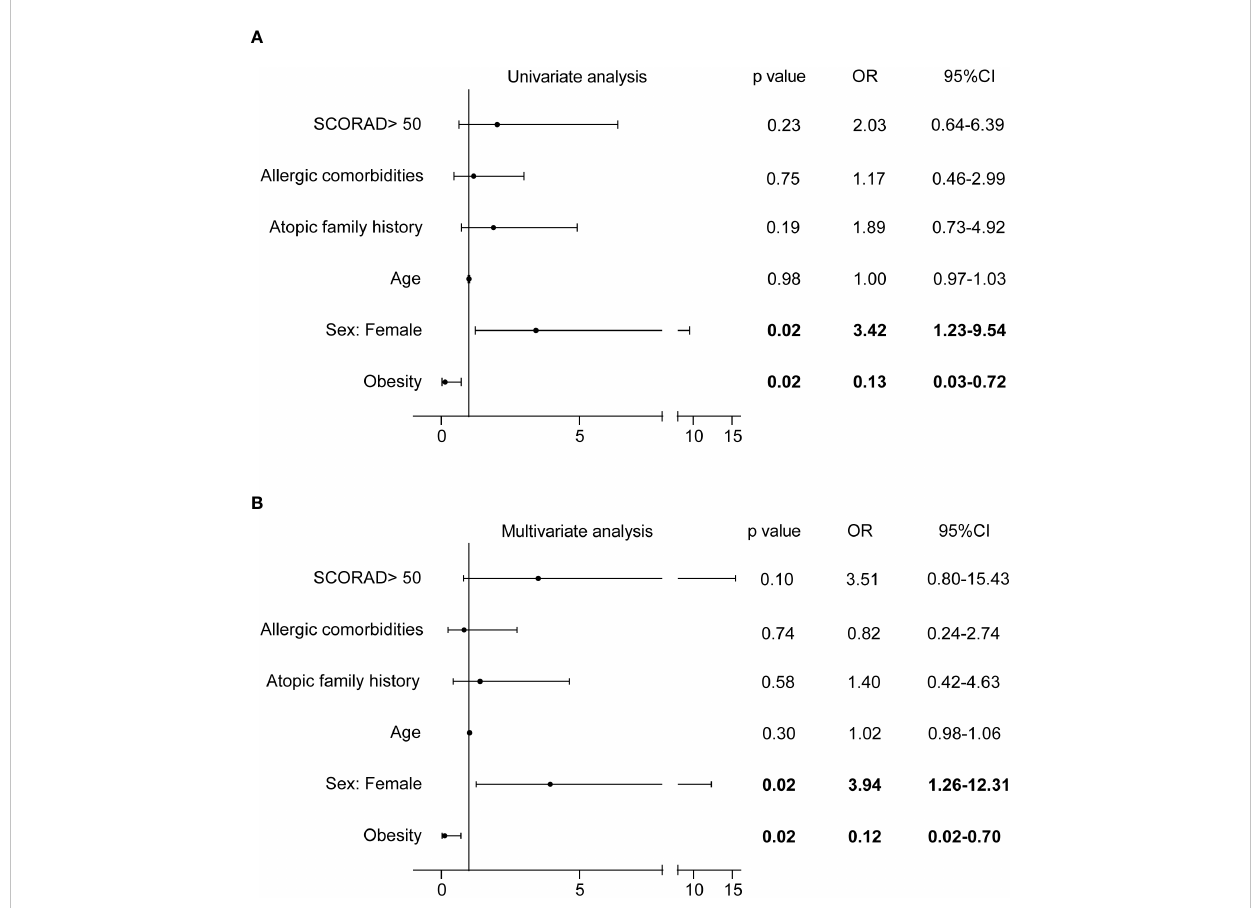
FIGURE 3 Correlation of clinical parameters with EASI75 at week 16. CI, con fi dence interval; EASI, Eczema Area and Severity Index; EASI-75, at least 75% improvement from baseline in EASI; OR, odds ratio; SCORAD, Scoring Atopic